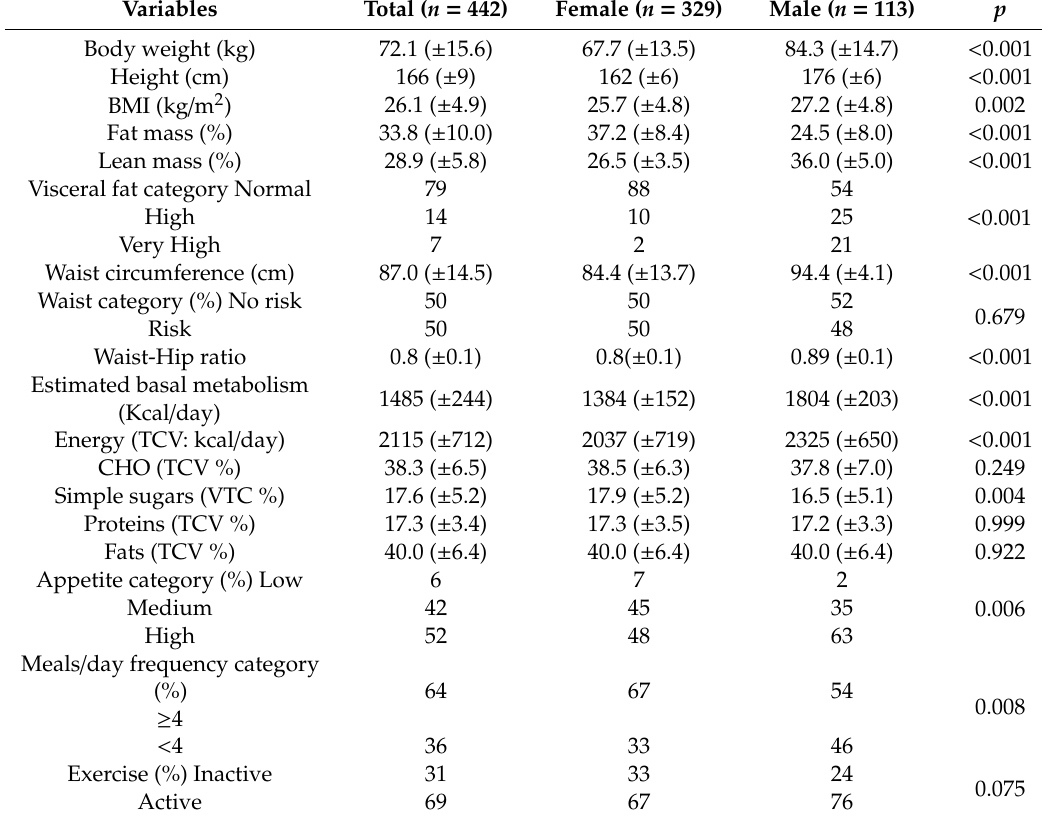
Table 1. General characteristics of the studied sample (X ± SD;